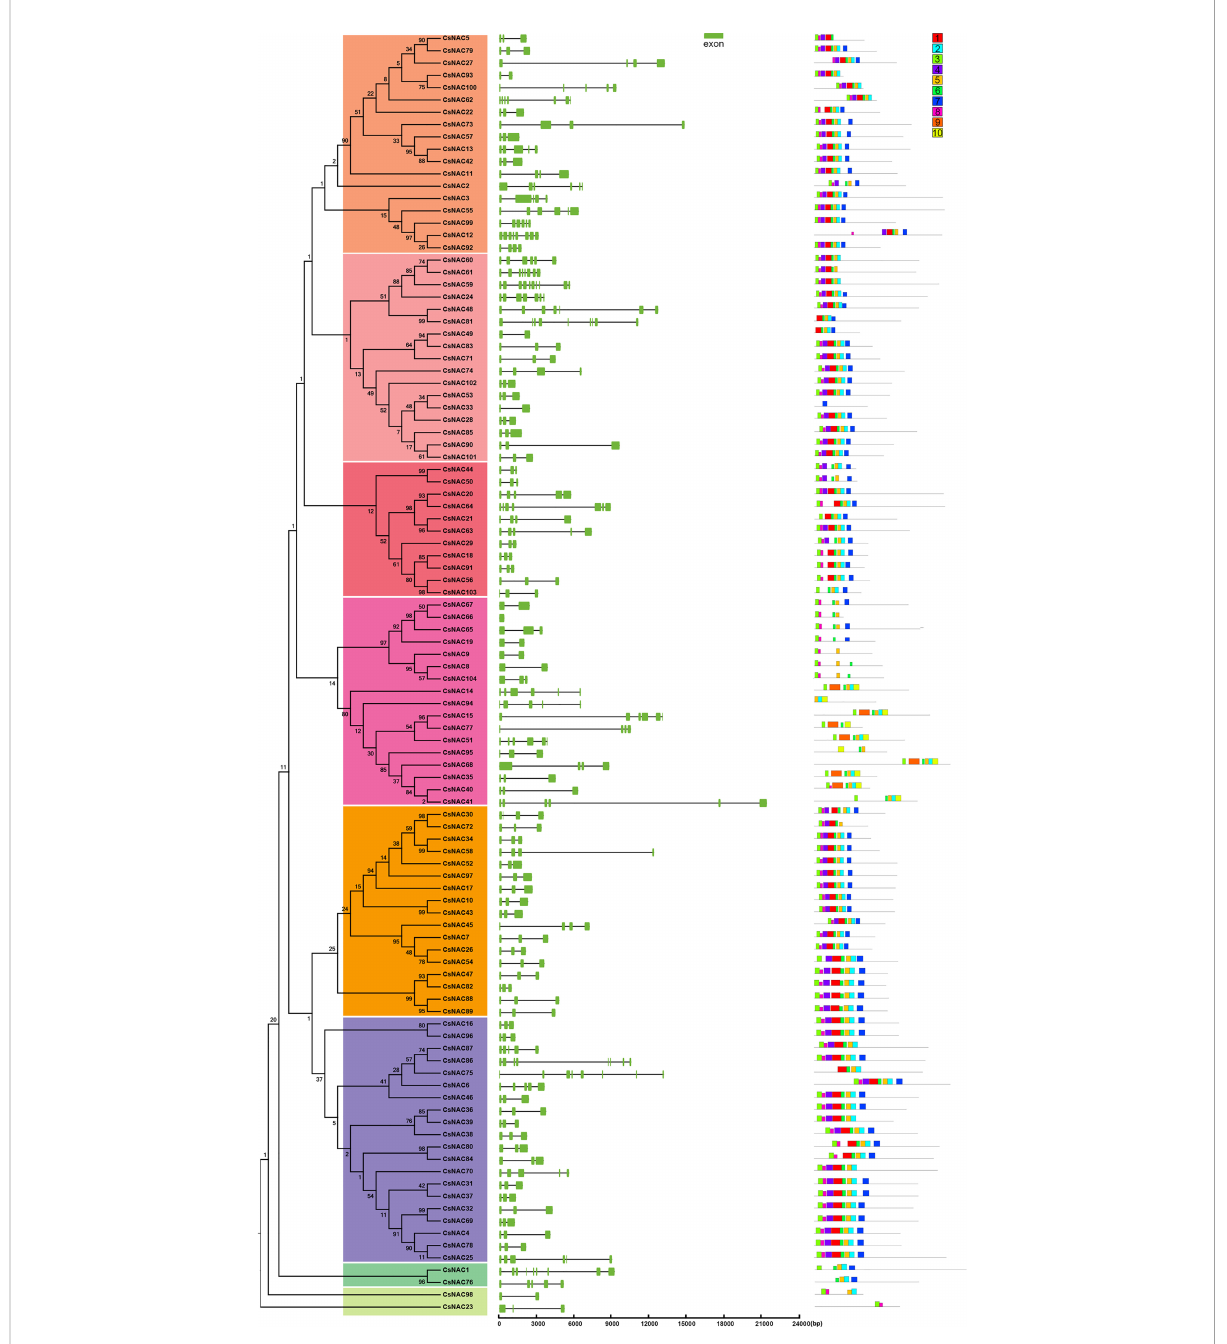
FIGURE 2 Gene structure and motif organization of NAC genes in C. sinensis . Intron and exon structures of NACs are graphically represented by black lines and orange boxes, respectively. The protein sequences of NACs was used to predict the conserved regions and motifs. Conserved motifs are indicated by a colored box numbered 1 to